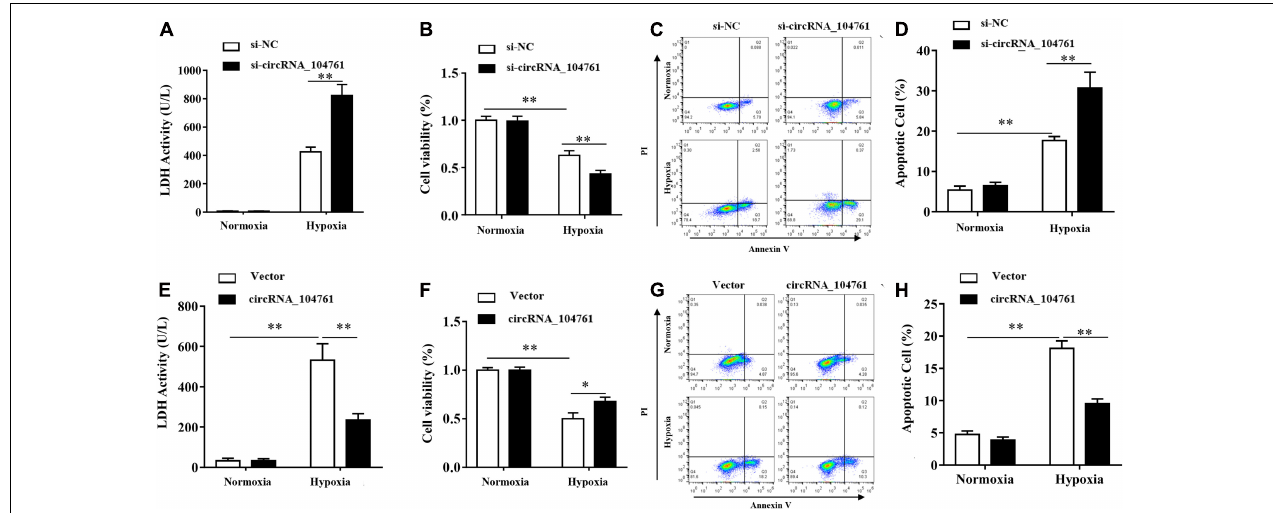
FIGURE 7 | Effect of circRNA_104761 knockdown and overpression in human cardiomyocytes AC16. (A–D) Effect of circRNA_104761 knockdown on AC16. (A) LDH activity test (Normoxia and Hypoxia). (B) Cell viability was determined by CCK8 assay. (C,D) Flow data analysis of apoptosis. (E–H) Effect of circRNA_104761 overexpression on AC16. (E) LDH activity test (Normoxia and Hypoxia). (F) Cell viability was determined by CCK8 assay. (G,H) Flow data analysis of apoptosis. Results are represented as means ± standard deviation (SD). Data shown in this graph was analyzed by independent sample t -tests with a significance level of 95%. ** p -value < 0.01 and * p -value <